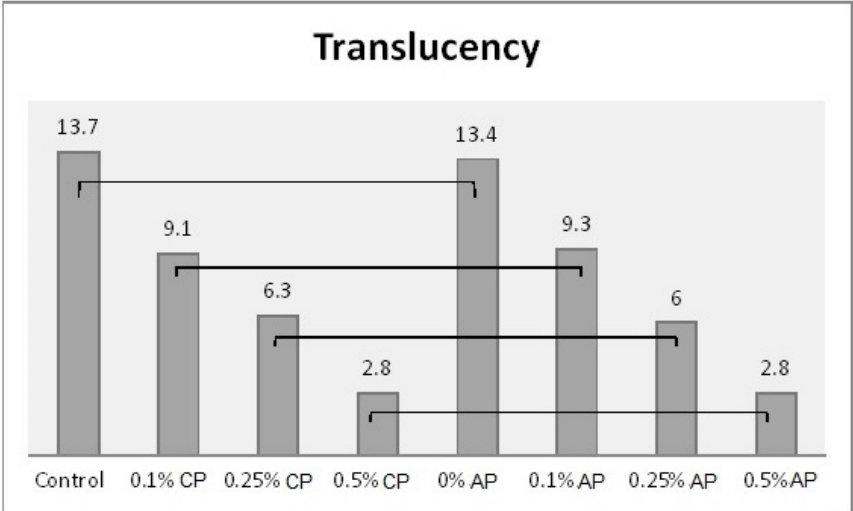
Figure 5. Mean of translucency and significances between groups for ND concentrations and polymerization techniques. Lines show statistically insignificant differences in means comparing polymerization techniques.